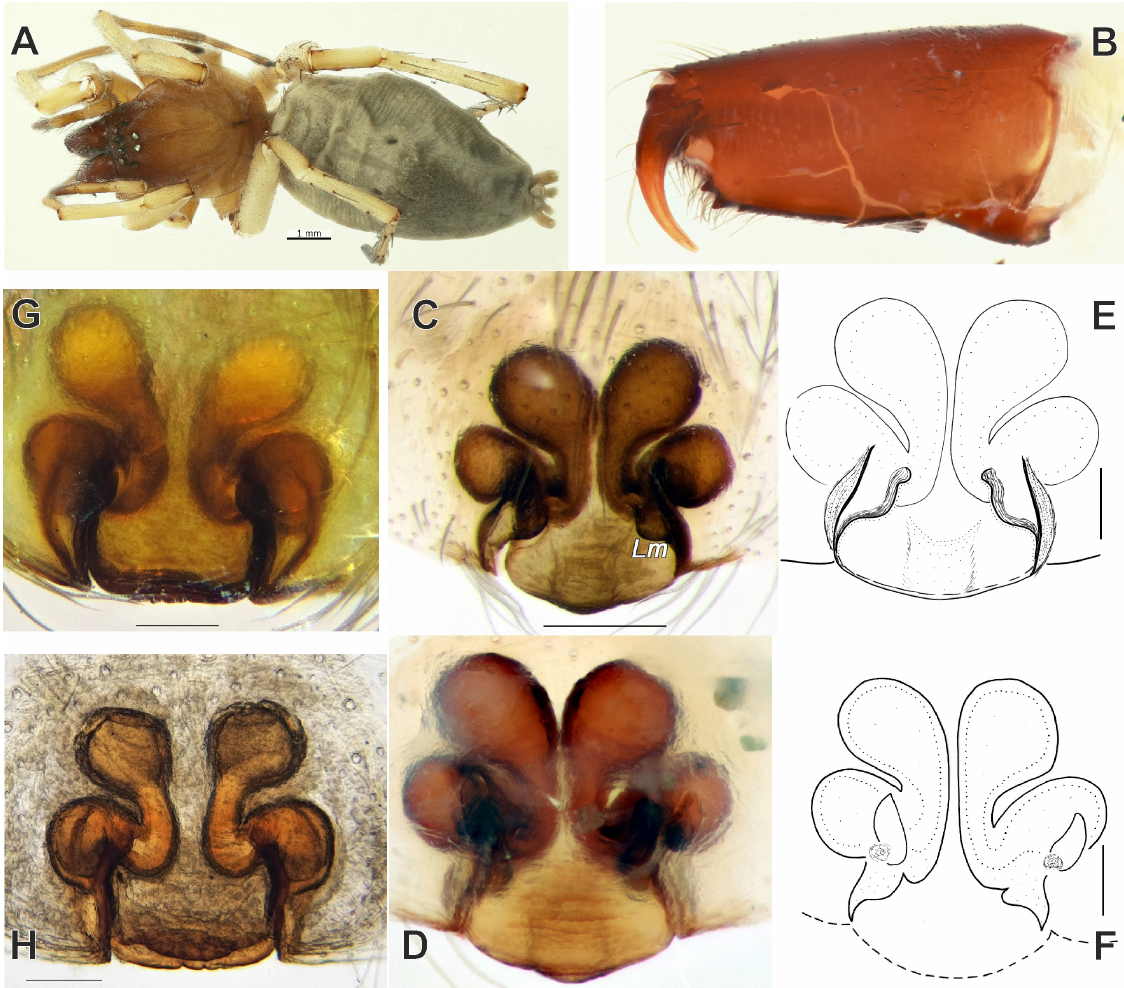
Fig. 8. A–F . Drassodes persianus sp. nov., holotype, ♀ (MHNG). A . Habitus, dorsal view. B . Chelicera, prolateral view. C, E . Epigyne, ventral view. D, F . Epigyne, dorsal view. – G–H . D . longispinus Marusik & Logunov, 1995, ♀ (PSU-8263). G . Epigyne, ventral view. H . Epigyne, dorsal view. Abbreviation: Lm = lateral margin. Scale bars: A = 1 mm; C = 0.2 mm; E–H = 0.1